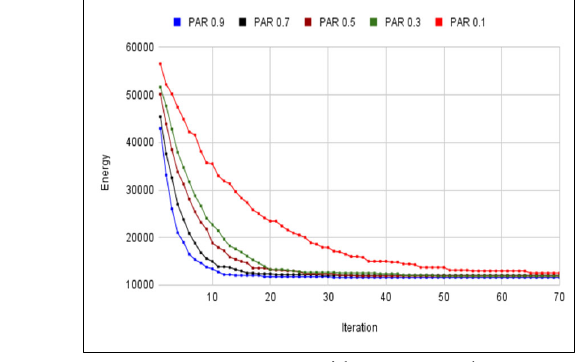
Fig. 5. Instance with 100 PM and 200 VM Fig. 6. Instance with 200 PM and 300 VM